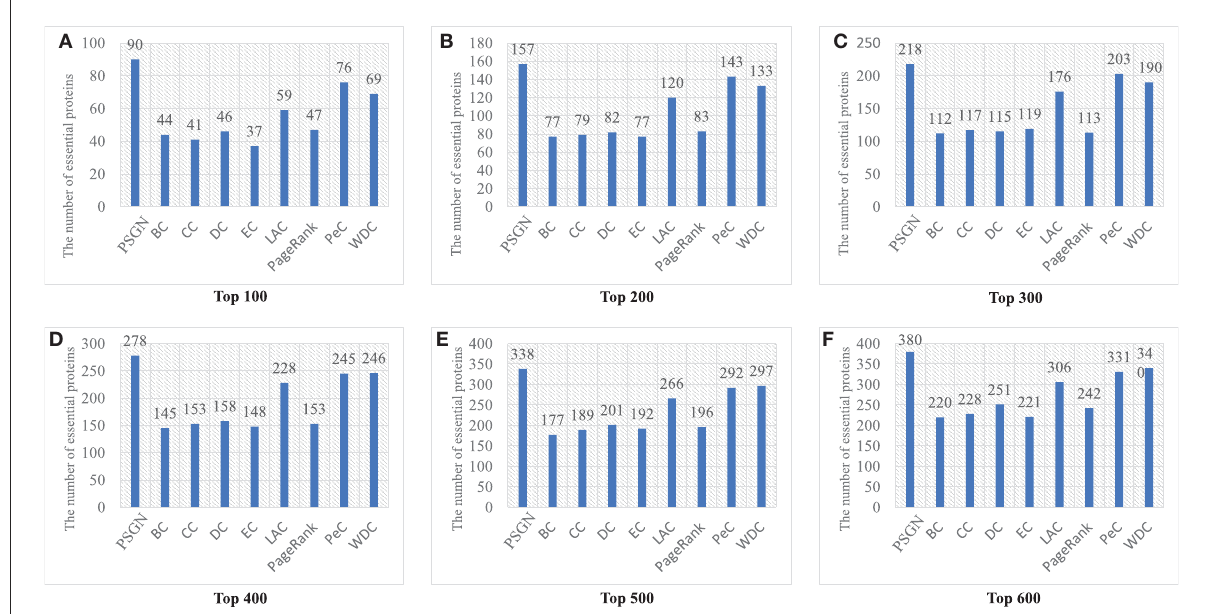
FIGURE4 The number of essential proteins predicted by PSGN, BC, CC, DC, EC, LAC, PageRank, PeC, and WDC. (A–F) show the results of these methods when selecting top 100 to 600 ranked proteins as candidates of essential proteins.